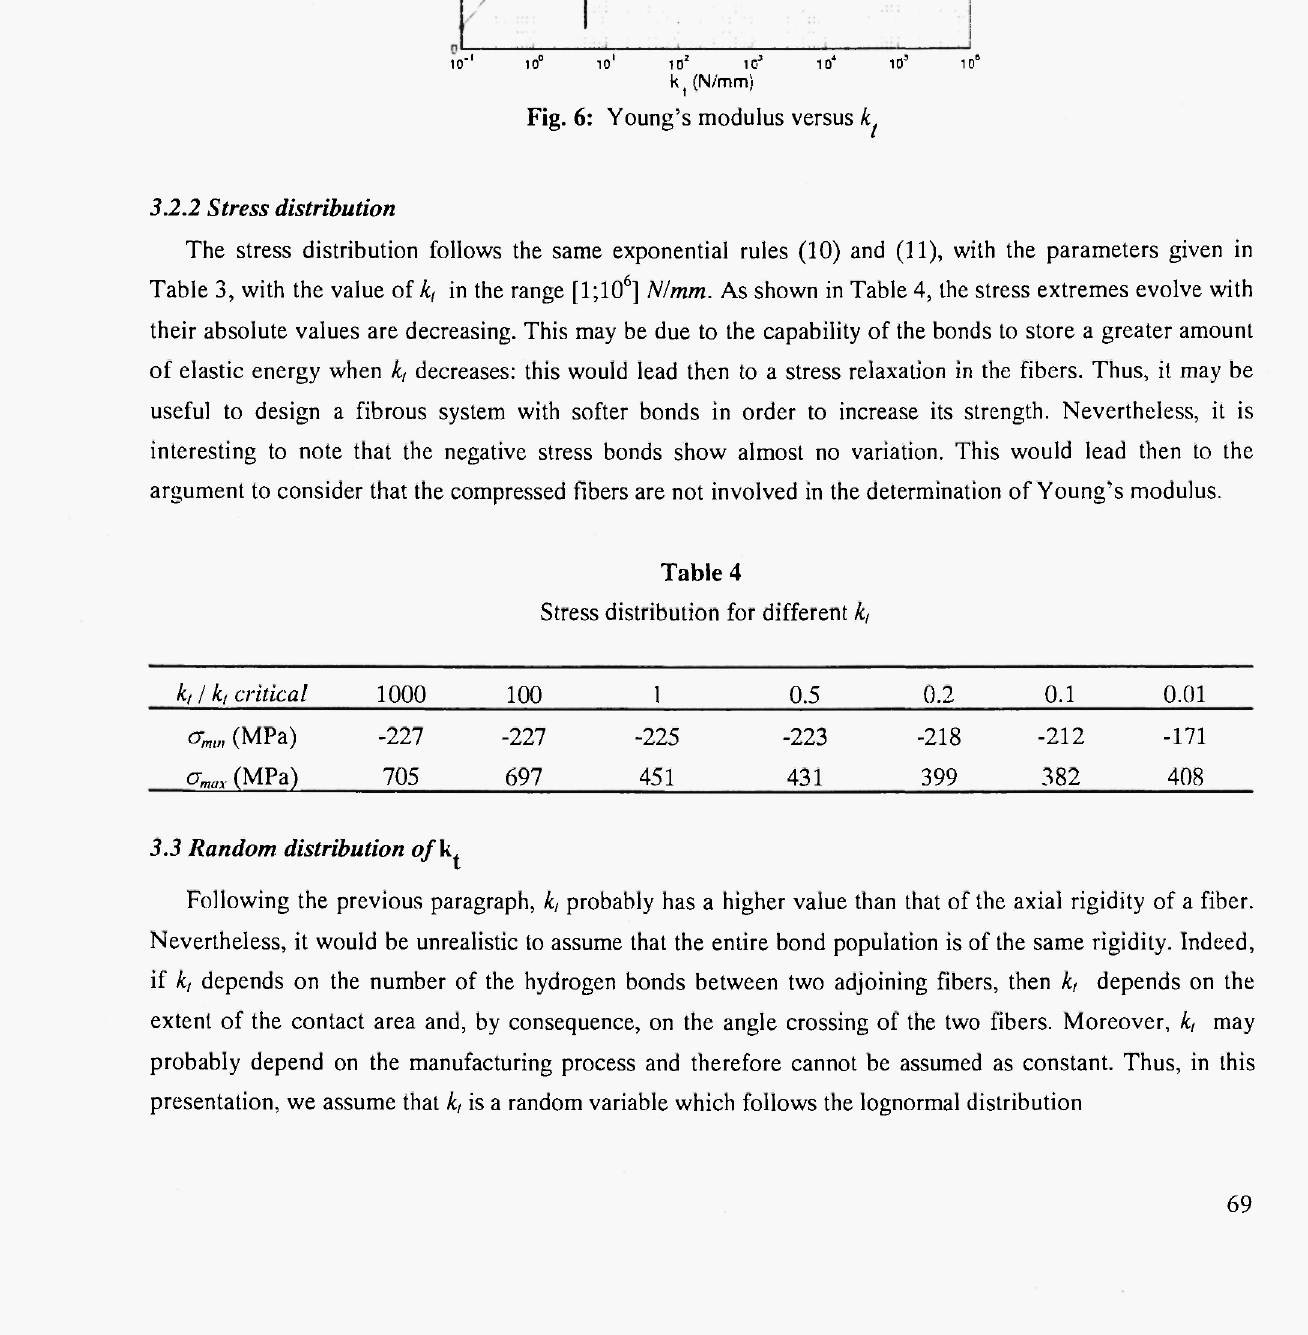
Fig. 6: Young's modulus versus k {